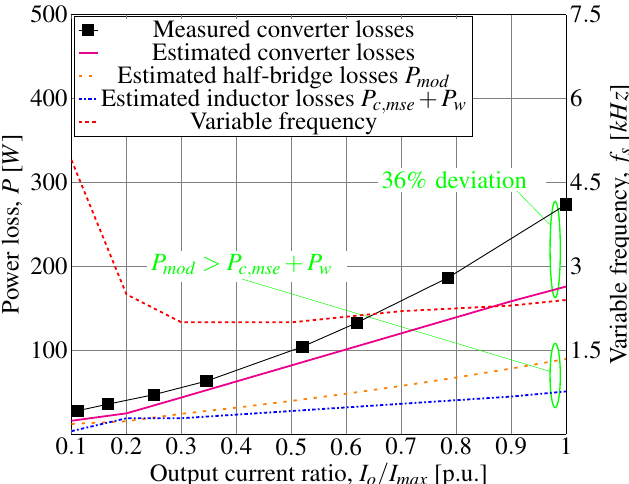
Figure 13. Power loss distribution of the converter for